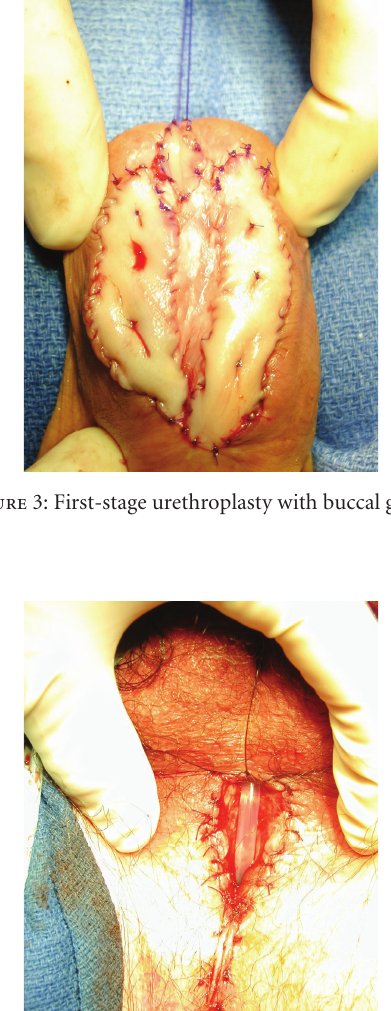
Figure 2: Typical retrograde urethrogram appearance of adult stricture after hypospadias repair showing a long stricture sparing only the bulbar urethra.